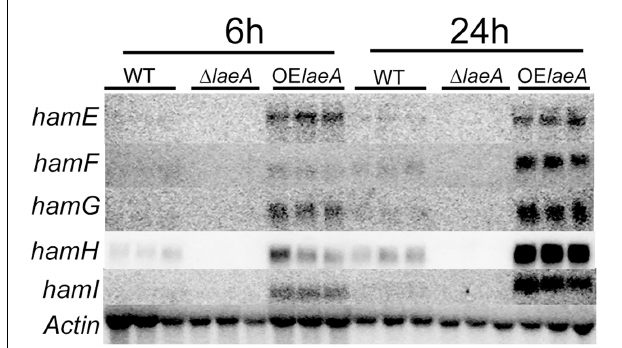
FIGURE 1 | Northern result of the ham genes in WT, (cid:49) laeA and OE:: laeA strains. 50 ml liquid YEP medium (6% peptone, 2% yeast extract) was inoculated with 10 6 conidia/ml of A. flavus NRRL3357, an laeA deletion strain or an laeA overexpression strain in 125 ml flasks, incubated with shaking at 250 rpm at 29 ◦ C. Treatments were triplicated. After 24 h, mycelia were collected and incubated in the aflatoxin-stimulating YES (6% sucrose, 2% yeast extract) medium for 6 h and 24 h (220 rpm, 29 ◦ C), respectively. hamE (AFLA_095770), hamF (AFLA_033600), hamG (AFLA_099760), hamH (AFLA_131310), hamI